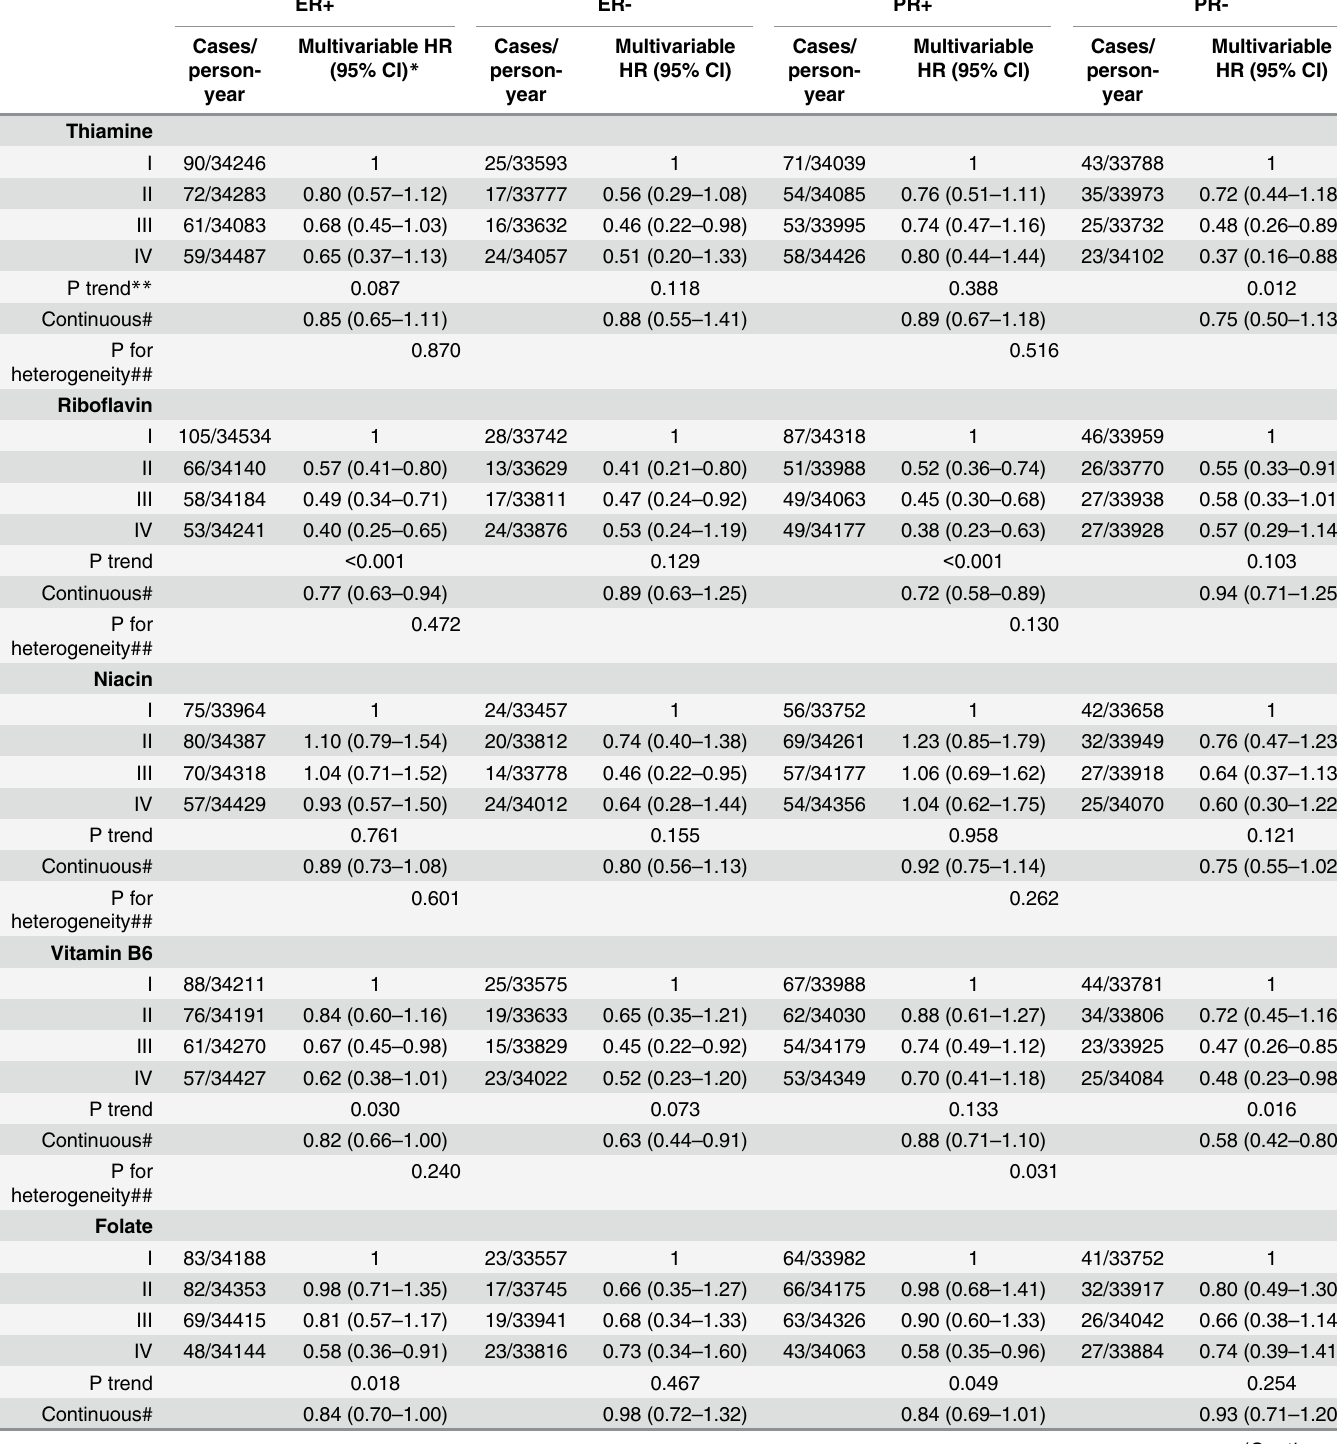
Table 3. HRs * (95% CIs) of breast cancer by ER and PR status in relation to quartiles of B vitamin intake in ORDET